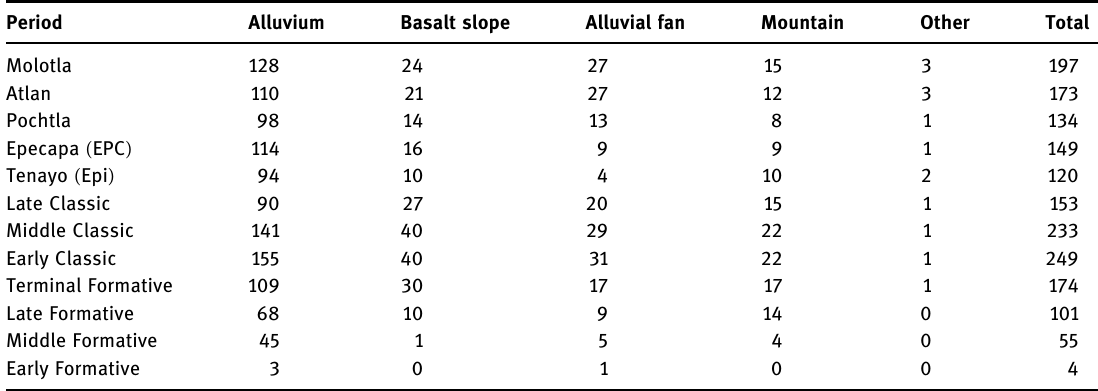
Table 4: Distribution of sites among environmental